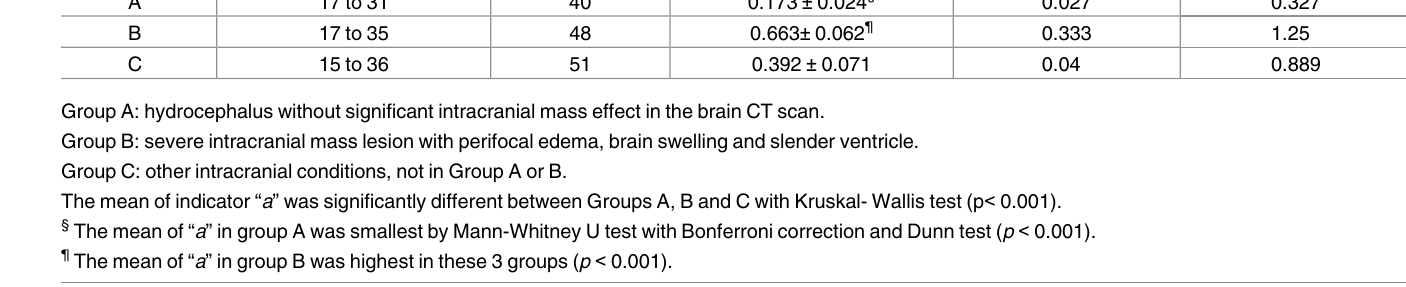
compared using the Kruskal- Wallis test showed significant differences between the three groups ( p < 0.001) (Table 3. The mean of indicator “ a ” in Group A was smallest from our results using the Mann- Whitney U test with Bonferroni correction and Dunn test ( p < 0.001) [Table 3]. The smaller values of “ a ” were always obtained in patients with prolonged intracra- nial hypertension and hydrocephalus without significant intracranial mass effect in the brain CT scan. On the other hand, the mean for indicator “ a ” in Group B was significantly higher than the other groups ( p < 0.001) [Table 3]. In the situation of an intracranial mass lesion with severe perifocal edema, brain swelling, and a slender ventricle, a much higher value of “ a ” was always observed.The mean for indicator “ a ” from other conditions, not including severe Table 3. The statistics for the indicator “ a ” in different intracranial conditions.